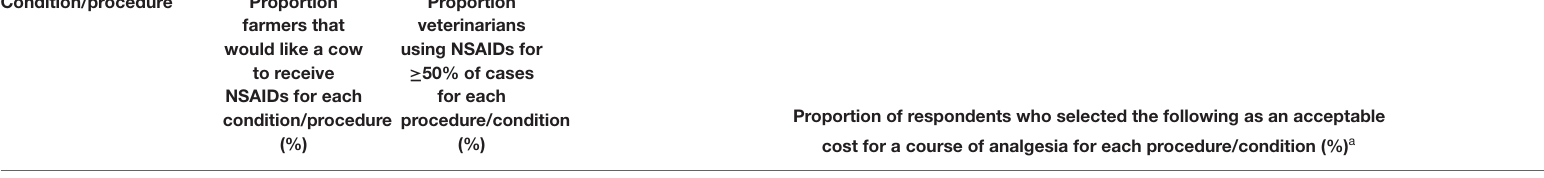
TABLE 3 | Proportion of farmers that would like a cow to receive NSAIDs for different conditions and procedures, and the proportion of veterinarians that give NSAIDs for ≥ 50% of cases for each condition and procedure, in a survey investigating attitudes to pain and analgesic use in pasture-based dairy